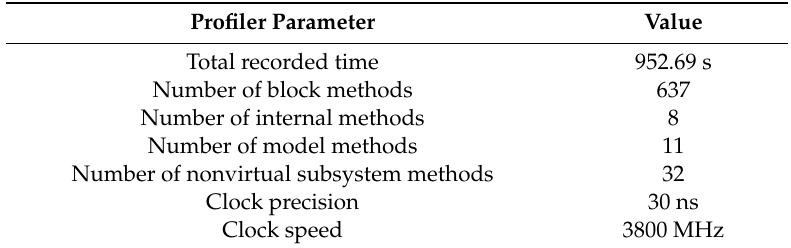
Table 6. Summary of the Simulink profiler applied to the global Simulink scheme.